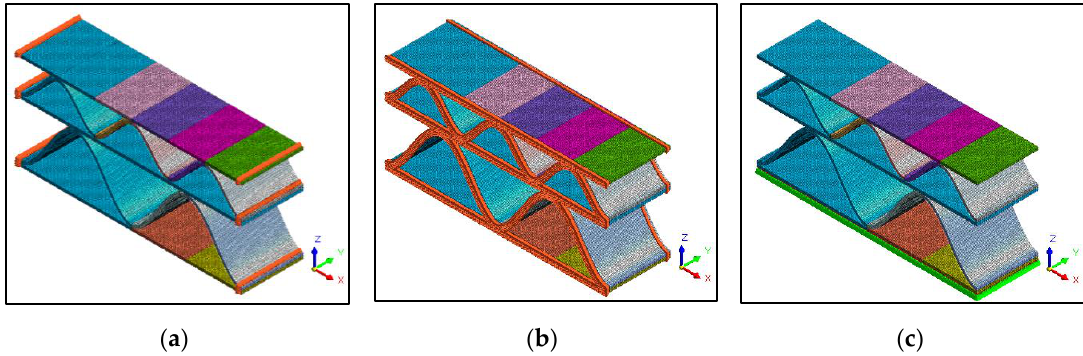
Figure 6. Boundary conditions applied when analyzing the reaction force for vertical displacement (Z) (example: AB/F-DW); they should be listed as: ( a ) U = 0, ( b ) V = 0, and ( c ) W = 0.